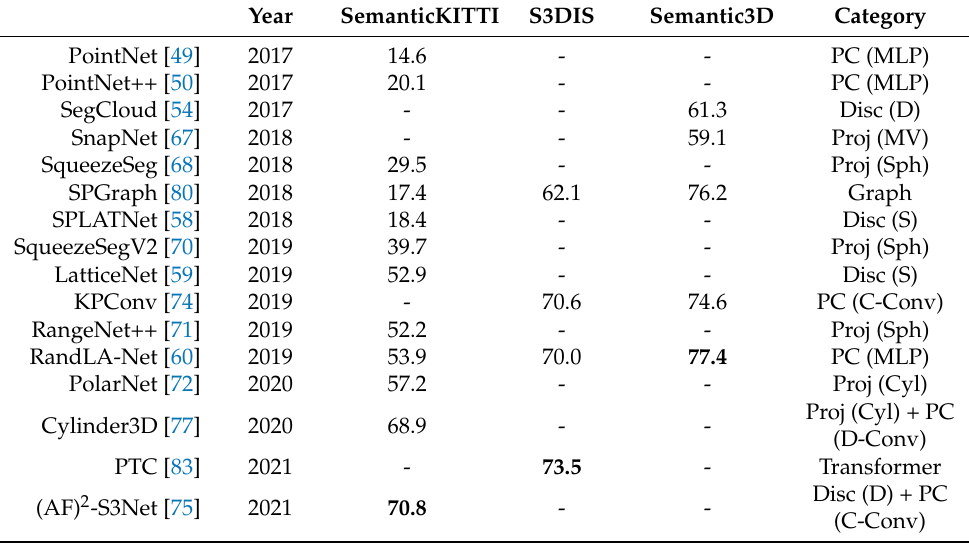
Table 2. Comparison of some of the main approaches for Point Cloud Semantic Segmentation in terms of mIoU percentage, on SemanticKITTI [35], S3DIS [44], and Semantic3D [33]